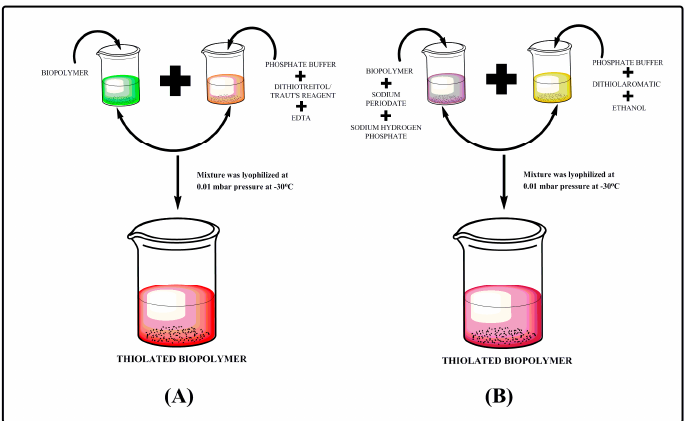
Figure 2. Step wise process of thiolation ( A ) by Traut’sreagent/dithiotreitol and( B) by dithiolaromatic.